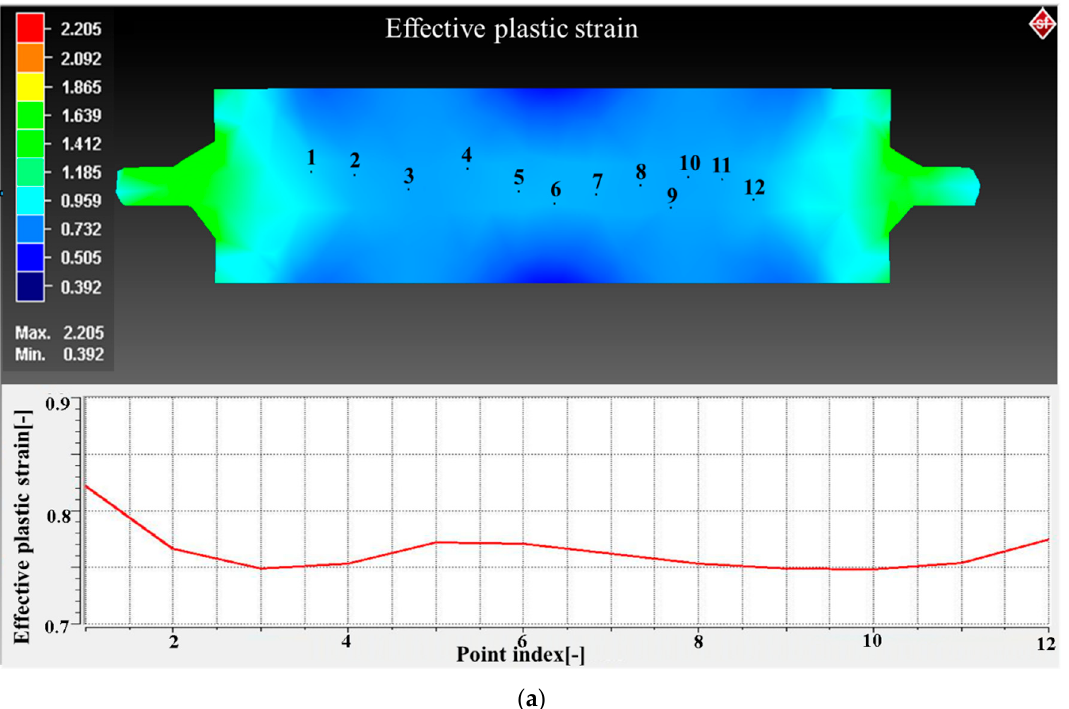
Table 3. Parameters used for simulation in Simufact software